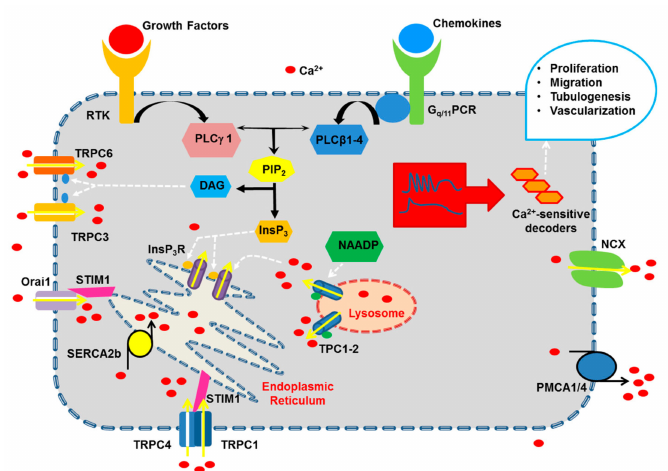
Figure 1. The pro-angiogenic Ca 2 + toolkit in vascular endothelial cells. Pro-angiogenic cues, such as growth factors and chemokines, bind to specific receptor tyrosine kinases (RTK) and G q / 11 -protein Coupled Receptors (G q / 11 PCR) thereby activating multiple phospholipase C (PLC) isoforms, which in turn cleave phosphatidylinositol 4,5-bisphosphate (PIP 2 ) into inositol-1,4,5-trisphosphate (InsP 3 ) and diacylglycerol (DAG). InsP 3 triggers Ca 2 + release from the endoplasmic reticulum (ER) through InsP 3 receptors (InsP 3 R), while DAG stimulates extracellular Ca 2 + entry through TRPC3 and TRPC6. However, the major Ca 2 + -entry pathway in vascular endothelial cells is provided by store-operated Ca 2 + entry (SOCE), which is mainly mediated by the physical interaction between STIM1 and Orai1. In addition, SOCE may be sustained by the interplay among STIM1, Transient Receptor Potential (TRP) Canonical 1 (TRPC1) and TRPC4, with [35] or without the involvement of Orai1. Endogenous Ca 2 + release may also be sustained by ryanodine receptors (RyR, not shown) and by endolysosomal two-pore channel 1-2 (TPC1-2), which are gated by nicotinic acid adenine dinucleotide phosphate (NAADP). Multiple Ca 2 + -transporting systems maintain resting Ca 2 + concentration and clear cytosolic Ca 2 + after the pro-angiogenic signal. These include Sarco-Endoplasmic Reticulum Ca 2 + -ATPase 2a (SERCA2a), Plasma Membrane Ca 2 + -ATPase 1 (PMCA1) and PMCA4, and Na + / Ca 2 + exchanger (NCX). Please, see the text for a more detailed description of how the endothelial Ca 2 + toolkit is recruited by pro-angiogenic